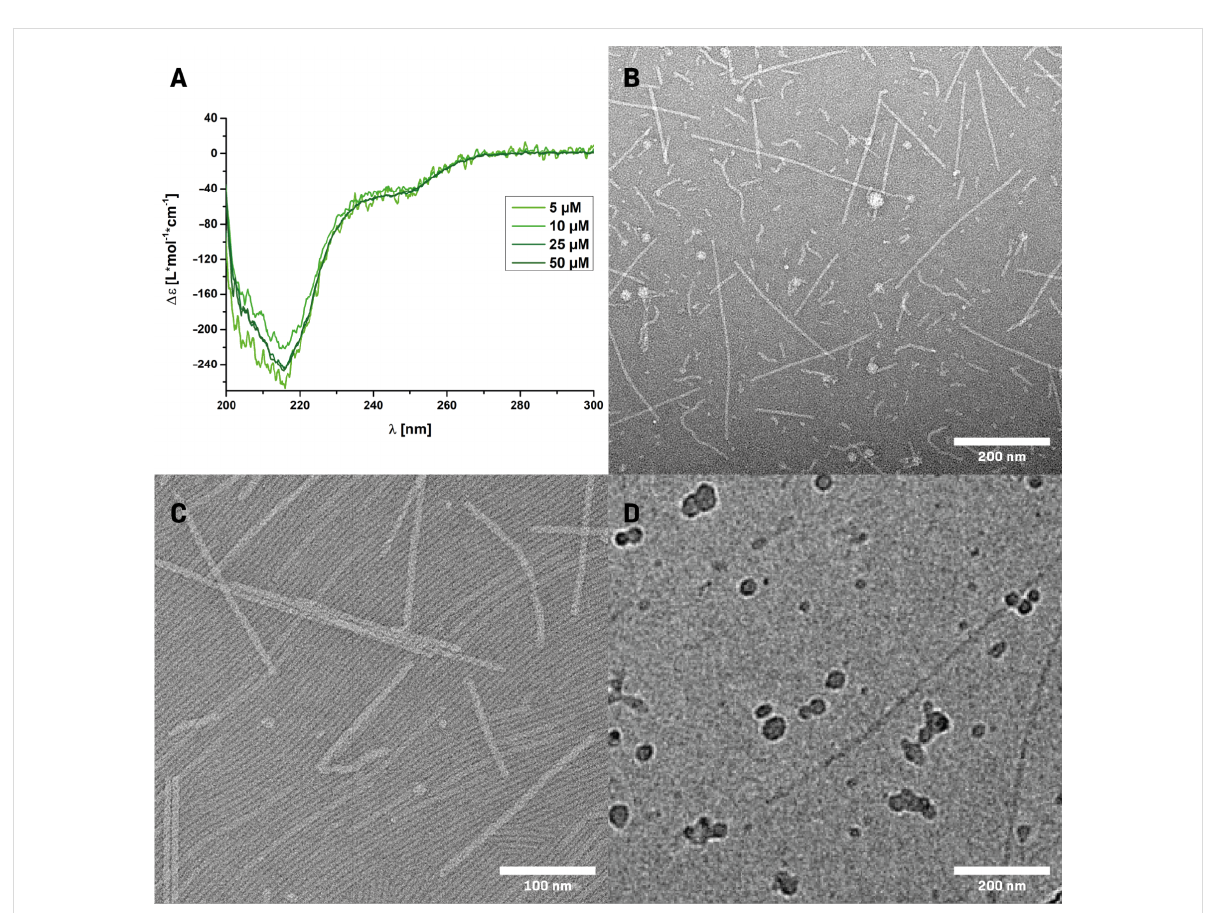
Figure 1: Analysis of the self-assembly behavior of I by A: CD-spectra of 5, 10, 25 or 50 µM aqueous solutions; B, and C: TEM micrographs of nega- tively stained 25 µM solutions in water; D: cryo-TEM micrograph of I (50 µM) in PBS ( − / − ) with 100 mM